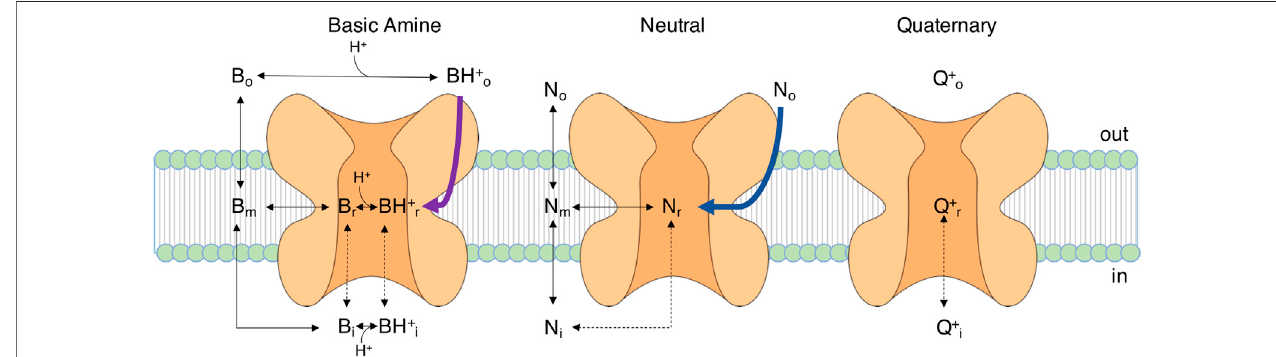
FIGURE3| EntrypathwaysofLAswithdifferentchemicalproperties.DiagramofthemovementsofdifferentlychargedLAmolecules(B,basicamine,N,neutralLA, Q, quaternary charged LA) to and from the channel. Black dashed lines are transitions requiring open activation and fast inactivation gates, as the drug enters from the intracellularside.Blacksolidlinesaretransitionsprobablynotstronglydependingonthegatingstate.VioletandbluelinesindicatetwopathwaysobservedinMDstudies for lidocaine and benzocaine, respectively, (Boiteux et al., 2014; Nguyen et al., 2019), where the LA does not pass through the membrane phase but enters a lipophilic pathway within the channel protein towards the side fenestrations (see also Figure 4 ). Subscript characters represent membrane phase (m), receptor site (r), extracellular (o) and intracellular (i) space. The fi gure is based on the diagram reported in (Hille, 1977).